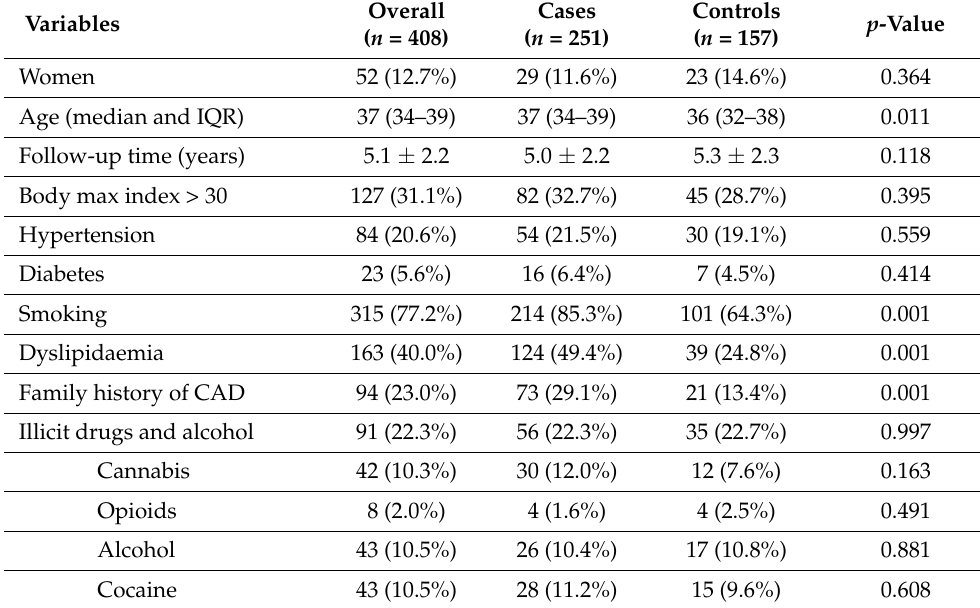
Table 1. Clinical characteristics of patients ≤ 40 years undergoing coronary